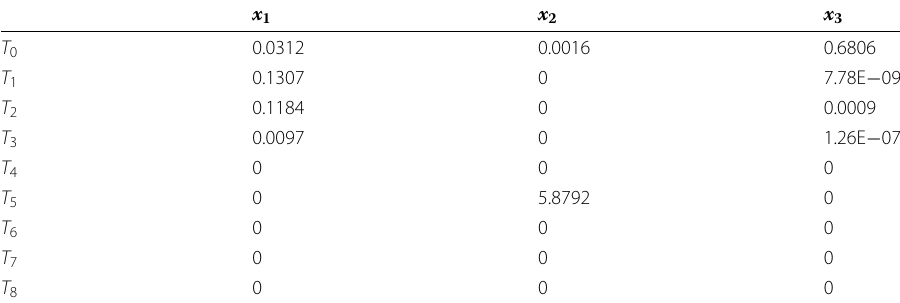
Fig. 7 Problem defined in Eq. (4.3): Comparison of predicted s 2 -PGD values with the reference ones in the testing set (the black line represents a perfect prediction) Table 1 Example of mode enrichment when constructing the s 2 -PGD solution of problem defined in Eq.